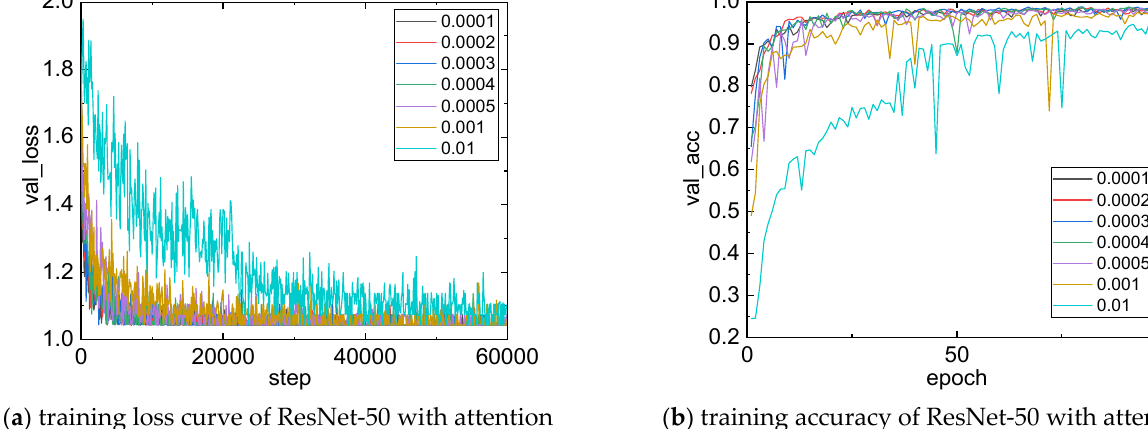
( a ) training loss curve of ResNet-50 with attention mechanism at different learning rate